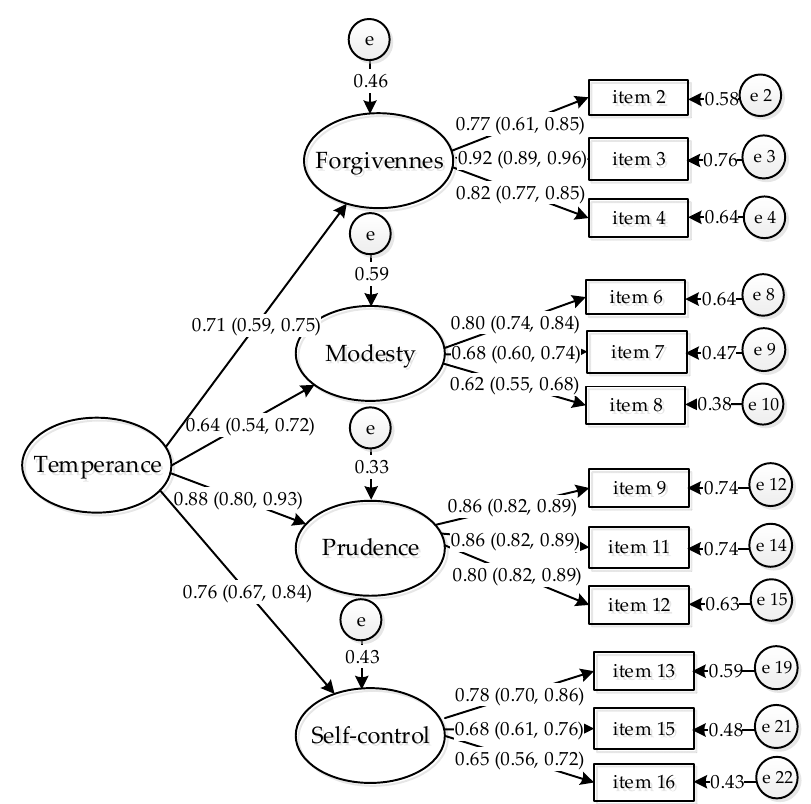
Figure 2. Final factor model of temperance depicting a one-dimensional second-order factor. Note: The 95% CI of the standardized factor loadings are represented in parentheses.